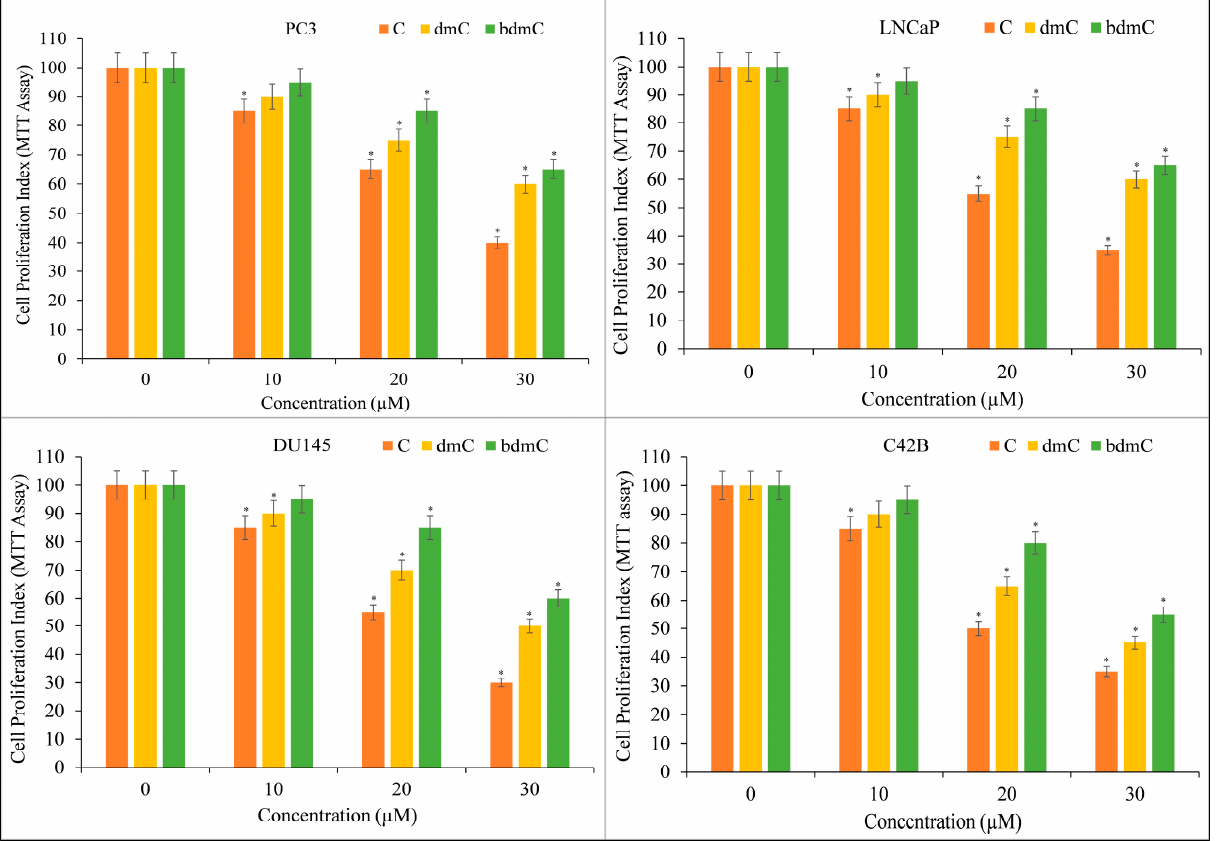
Figure 3. The MTT assay was used to determine the effect of C, dmC, and bdmC on cell proliferation in a variety of prostate cancer cell lines. PC3, LNCaP, DU145, and C42B were treated with the indi ‐ cated doses of curcuminoids for 72 h. As mentioned in Section 2, the effect on cell growth was